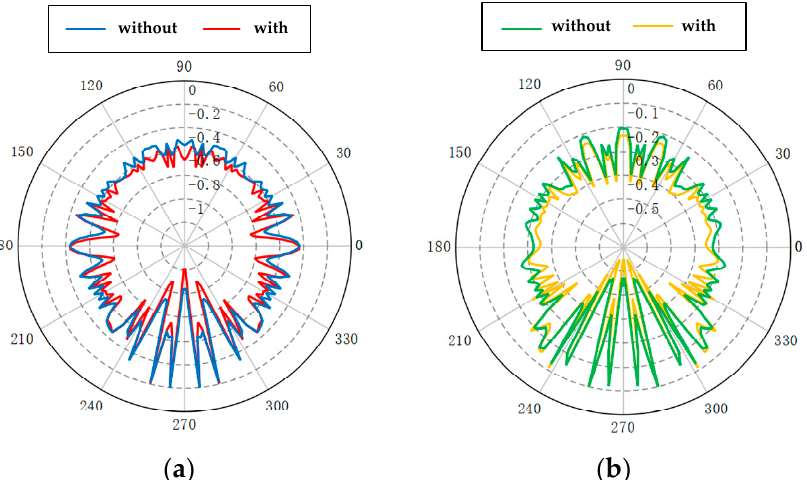
Figure 6. Comparison of passive interference results with and without auxiliary angle-steel under 16.7 MHz plane wave incidence. ( a ) Comparison of the dry-type tower; ( b ) Comparison of the cup-type tower.